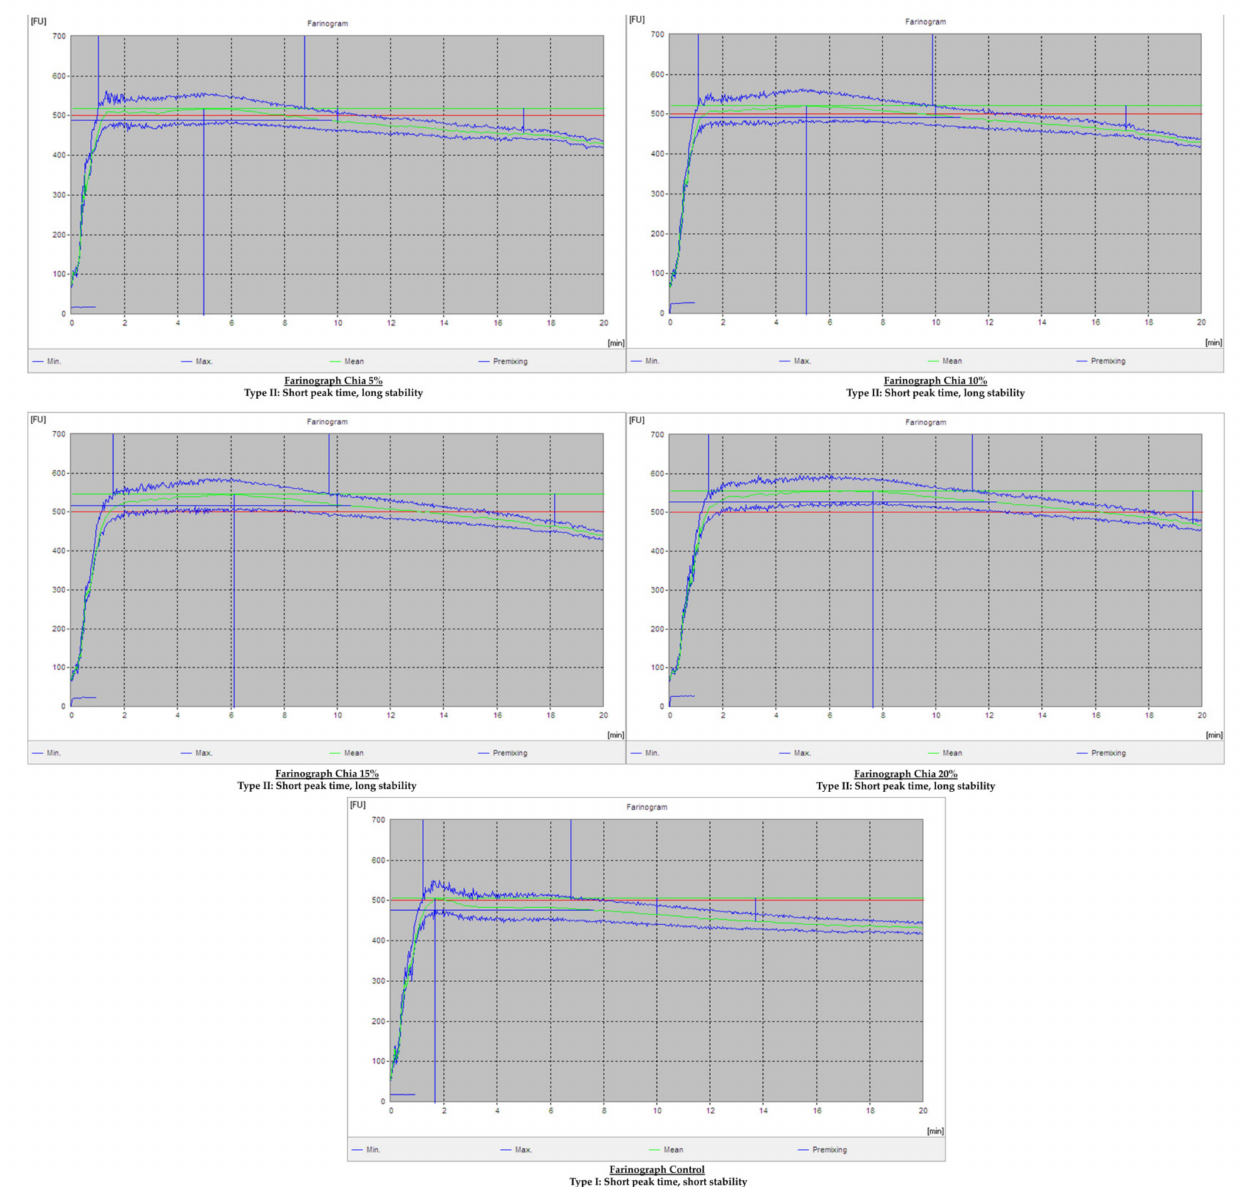
Figure 1. Farinographs of control and chia-supplemented